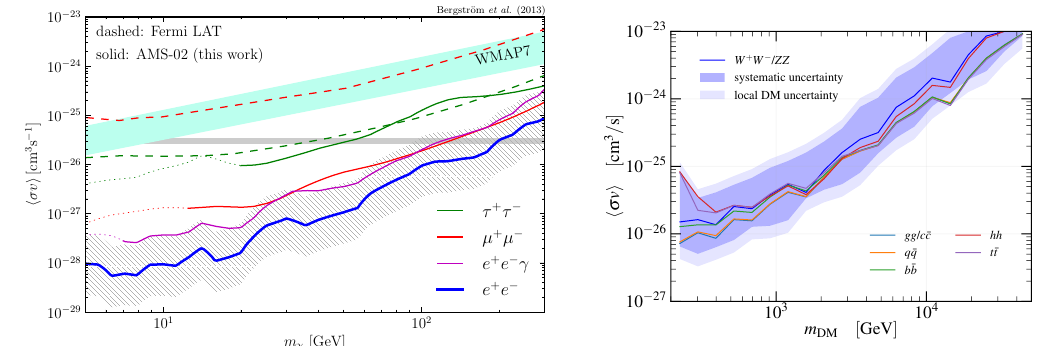
Figure 6: Limits from AMS-02 data on DM annihilation to (left) leptonic channels and (right) hadronic channels. In the left panel , dashed lines indicate bounds from Fermi observations of dwarf galaxies; the dotted portions of the solid constraint curves from AMS-02 are potentially affected by solar modulation effects. The hatched band around the e + e − constraint line indicates the estimated uncertainty due to systematic uncertainties in the local DM density and energy loss rate. In the right panel , the different colored lines represent the nominal constraint from antiproton observations for different hadronic final states, and the blue bands denote systematic uncertainties in the limit for annihilation to W and Z bosons. Reproduced from Ref. [ 95 ] ( left panel ) and Ref. [ 96 ] ( right panel